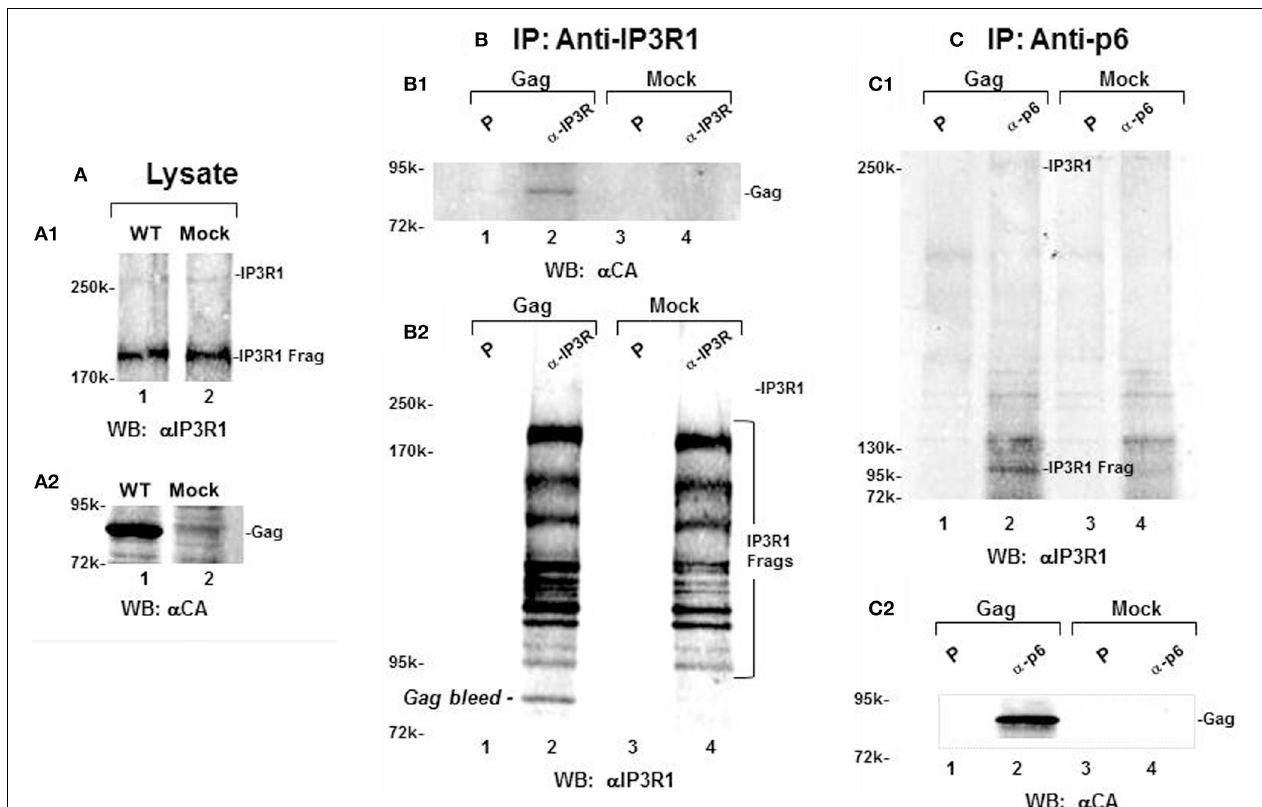
FIGURE 7 | Gag and IP3R can be reciprocally immunoprecipitated. (A) Total lysate from cells transfected with Gag ( lane 1 ) or from mock-transfected cells ( lane 2 ) probed for IP3R ( A1 , top ) and Gag ( A2 , bottom ). (B,C) Immunoprecipitation of Gag by anti-IP3R antibody (B) or by anti-p6 antibody (C) . Total lysates were mixed with either